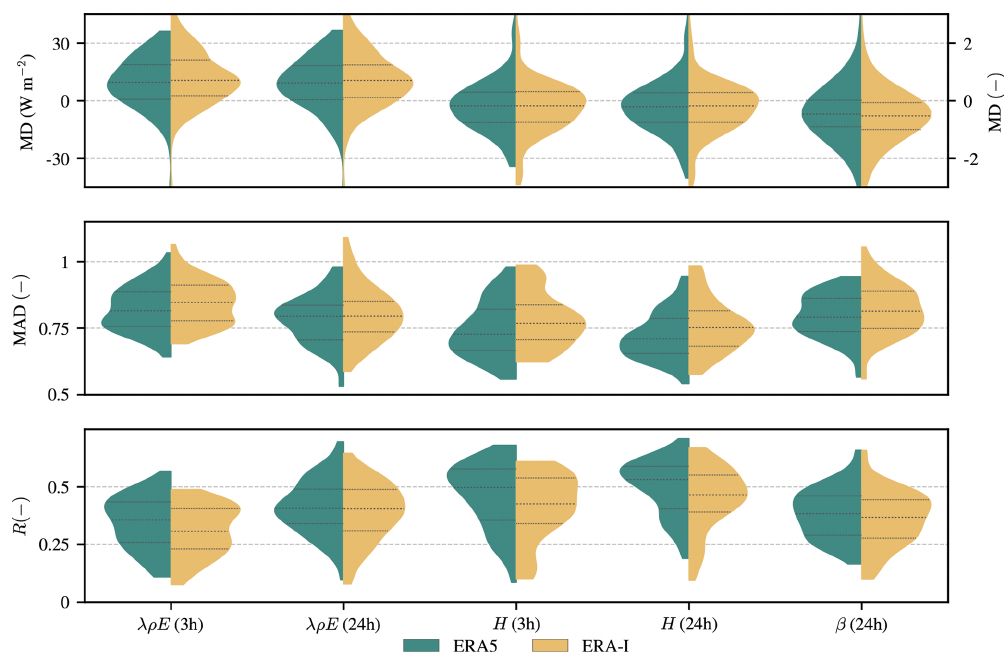
Figure 2. Violin plots of temporal validation statistics of the surface latent heat flux ( λρE ), surface sensible heat flux ( H ), and Bowen ratio ( β ) from ERA5 (green) and ERA-I (yellow). Statistics are calculated against in situ eddy-covariance measurements at both 3-hourly and daily temporal resolutions. Violin plots represent the distribution of the individual validation statistics with indication of the median and interquartile range and are calculated using a kernel density estimation approach. Statistics include the MD (raw in situ time series from 143 sites as reference), MAD (anomaly in situ time series from 77 sites as reference), and R (anomaly in situ time series from 77 sites as reference). The distribution of the MD of β is plotted on the right y axis. Table 1. Averaged metrics and their confidence interval of surface energy partitioning from ERA5, ERA-I, GLEAM+ERA5, and GLEAM+ERA-I across the FLUXNET 2015 data set. n/a – not